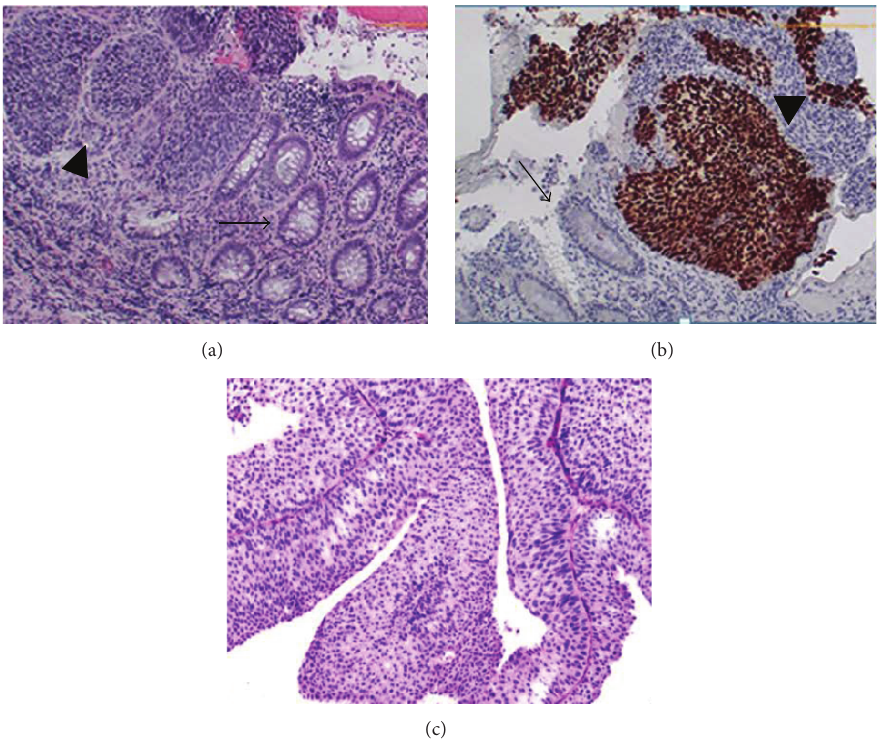
Figure 2: Representative images of (a) nests of flat, nonpapillary TCC (arrow head) within colonic epithelium (arrow) typical of cloacogenic TCC in rectum (H&E × 100). (b) p63 immunoperoxidase stain shows nuclear staining in the nests of cloacogenic TCC and negative staining in colonic epithelium (arrow) ( × 100). (c) High-grade papillary urothelial TCC ( ×